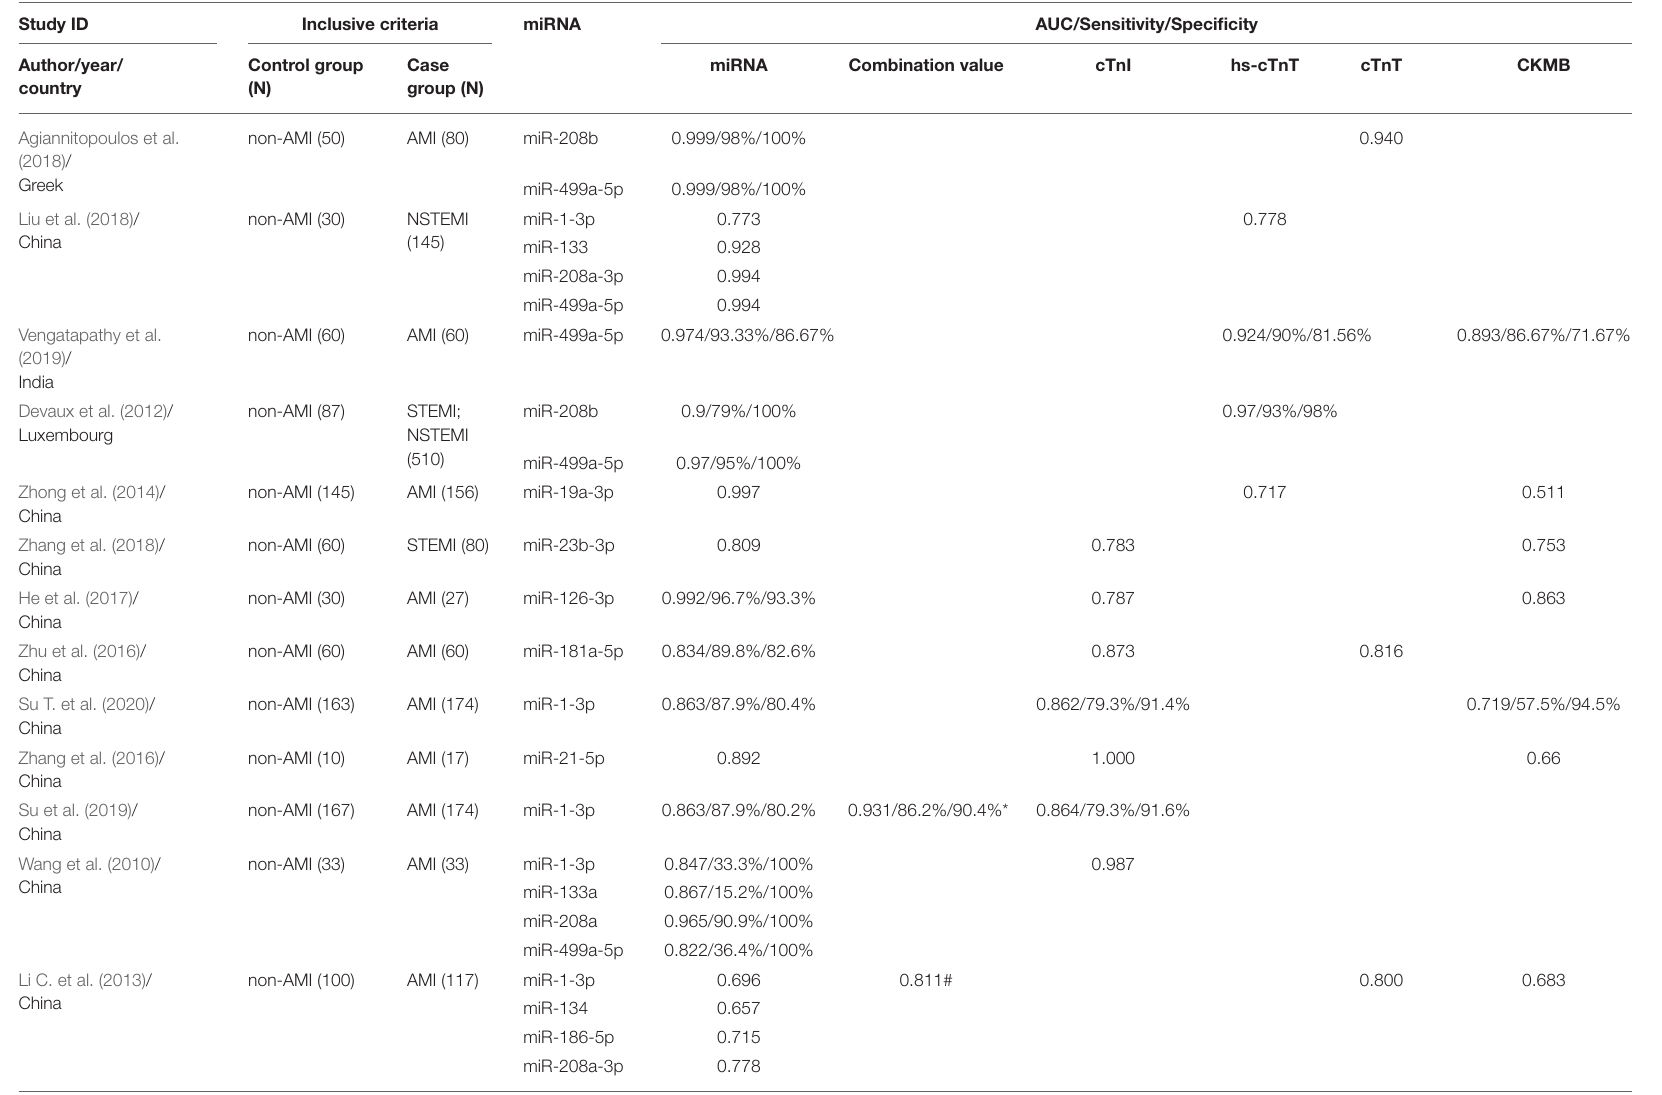
TABLE 2 | AUC comparison of miRNAs and conventional